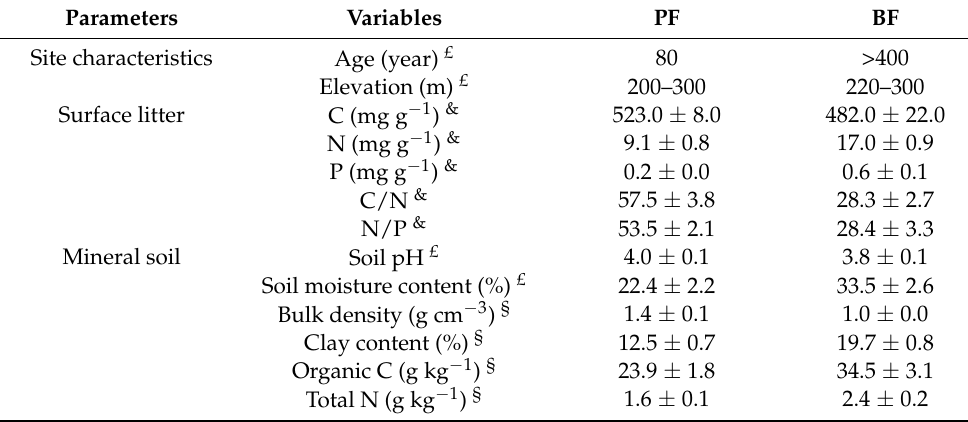
Table 1. Site characteristics and surface litter/mineral soil properties in PF (Masson pine forest) and BF (evergreen broadleaved forest) at the Dinghushan Biosphere Reserve. Data with special character “ £ ”, “ & ”, and “ § ” were cited from Ref. [30], Ref. [11], and Ref. [26],